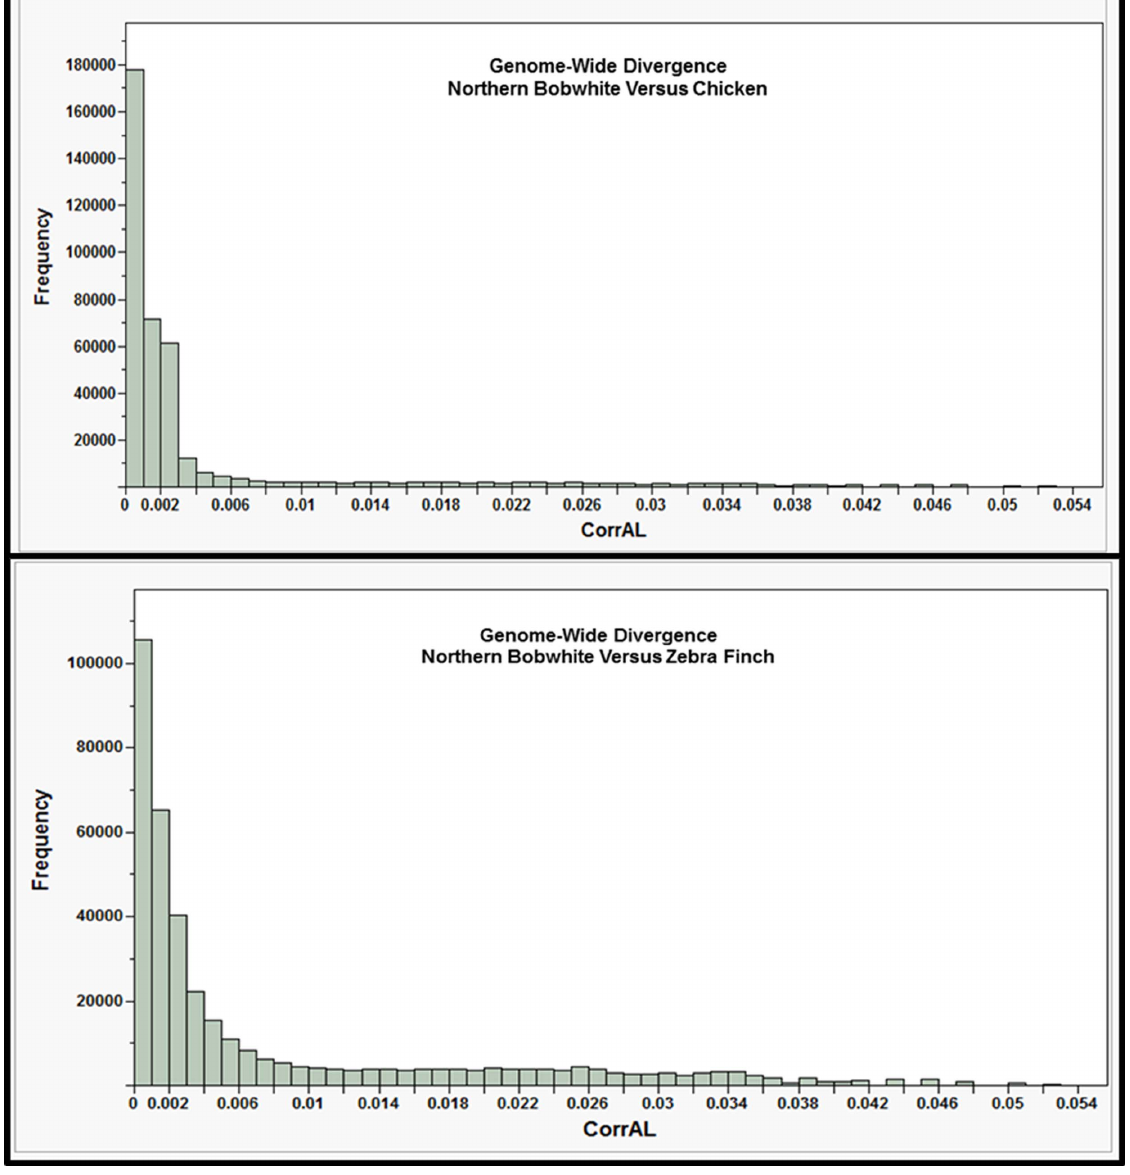
Figure 4. Whole Genome Analysis of Divergence. (Top) Genome-wide nucleotide-based divergence (CorrectedForAL) between the bobwhite ( Colinus virginianus ; NB1.0; simple de novo assembly) and the chicken genome ( Gallus gallus 4.0). (Bottom) Genome-wide nucleotide-based divergence (CorrectedForAL) between the bobwhite ( Colinus virginianus ; NB1.0; simple de novo assembly) and the zebra finch genomes ( Taeniopygia guttata 1.1, 3.2.4). Each histogram represents the full distribution of the composite variable defined as: CorrectedForAL= left edges of the distributions represent extreme conservation, whereas the right edges indicate extreme putative divergence. The observed ranges of the composite variable were 2.19545E-05 – 0.052631579 (chicken), and 4.28493E-05 – 0.052631579 (zebra finch). Distributional outliers were predicted using a percentile-based approach (99.98th and 0.02th) to construct interval bounds capturing . 99% of the total data points in each distribution. doi:10.1371/journal.pone.0090240.g004 Comparison of the bobwhite (NB1.0) and zebra finch genomes ( T. guttata 3.2.4) also revealed evidence for extreme nucleotide conservation and divergence (Fig. 4; Table 5; Table S11). In comparison to the zebra finch genome, two general trait classes (osteogenic, cardiovascular) were routinely associated with loci predicted within or immediately flanking the aligned positions of bobwhite contigs (NB1.0) classified as outliers for extreme